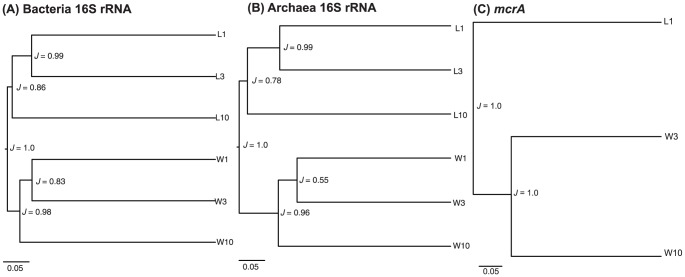
UniFrac clustering of environments based on genetic distance.Three clusters are shown: (A) bacterial 16S; (B) archaeal 16S; (C) mcrA sequences. Samples are letter-coded: L for lake and W for wetland environments; numbers indicate sampling depths of 1, 3 and 10 cm. Scale bars show the distance between clusters in UniFrac units. Numbers adjacent to each node indicate the fraction J of times this node was recovered among 100 replicates.